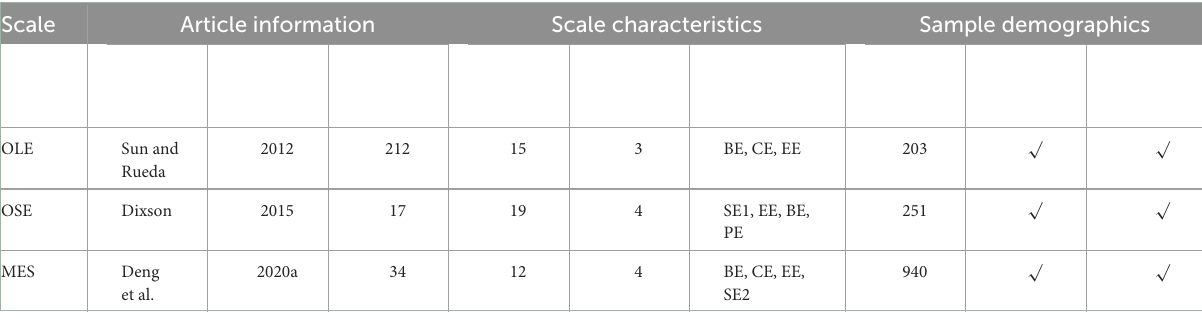
TABLE 9 Scales used to measure learning engagement in massive open online